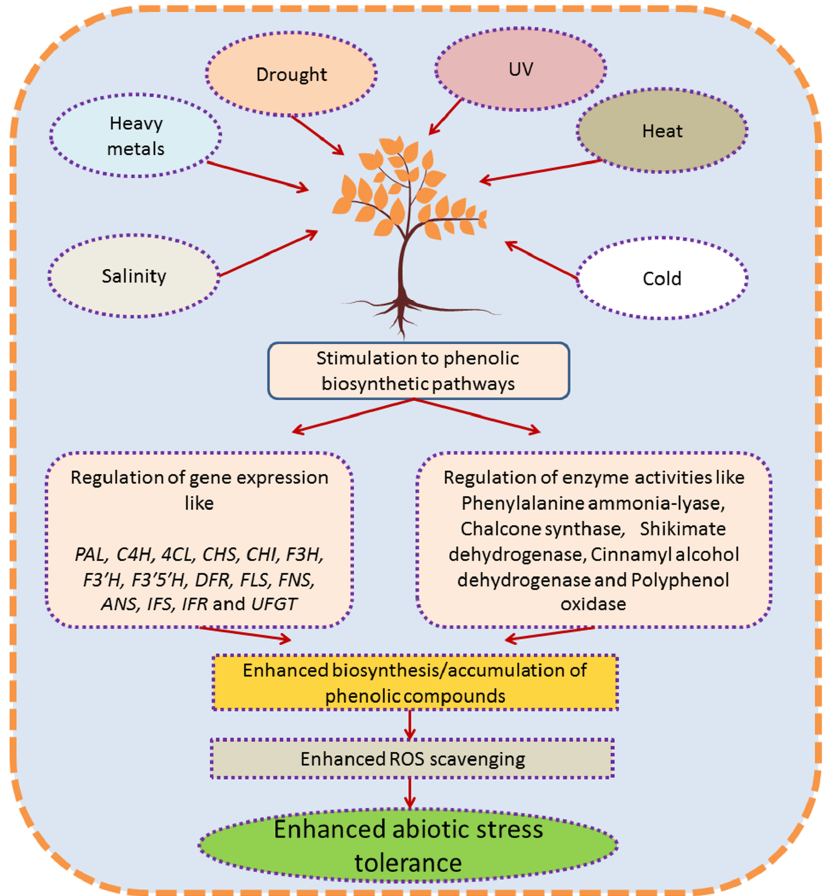
Figure 2. Diagrammatic explanation for response and role of phenolic compounds in plants growing under abiotic stress conditions. ROS (reactive oxygen species); PAL (phenylalanine ammonia lyase); CHS (chalcone synthase); CHI (chalcone isomerase); C4H (cinnamate 4-hydroxylase); 4CL (4-coumarate: CoA ligase); F3H (flavanone3-hydroxylase); F3′H (flavonoid 3′-hydroxylase); F3′5′H (flavonoid 3′5′-hydroxylase); FLS (flavonol synthase); FNS (flavone synthase) UFGT (UDP flavonoid glycosyltransferase); IFS (isoflavone synthase); IFR (isoflavone reductase); DFR (dihydroflavonol 4-reductase); ANS (anthocyanidin synthase).